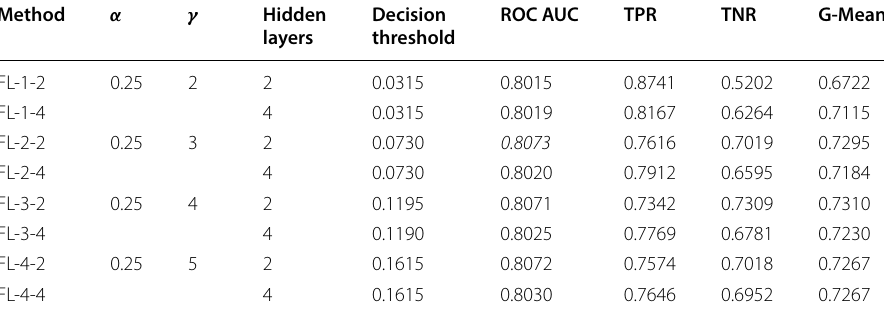
Italic font indicates the maximum ROC AUC score